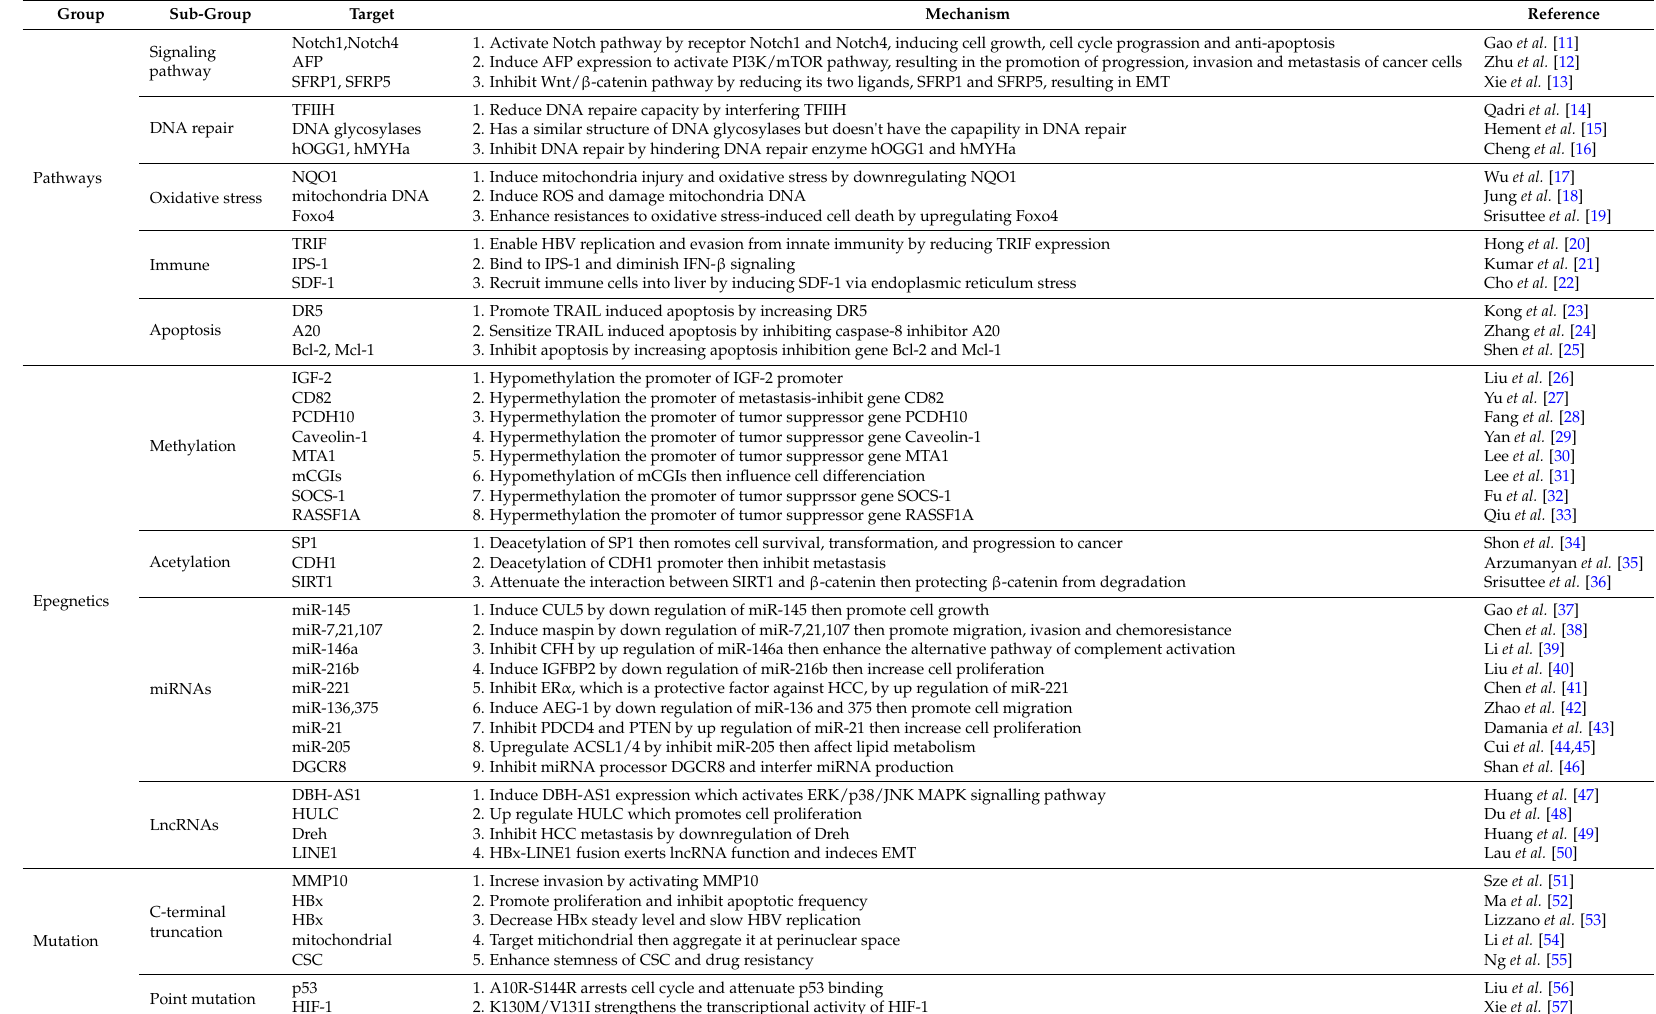
Table 1. Reported mechanisms of HBx on the various pathways, epigenetic and genetic